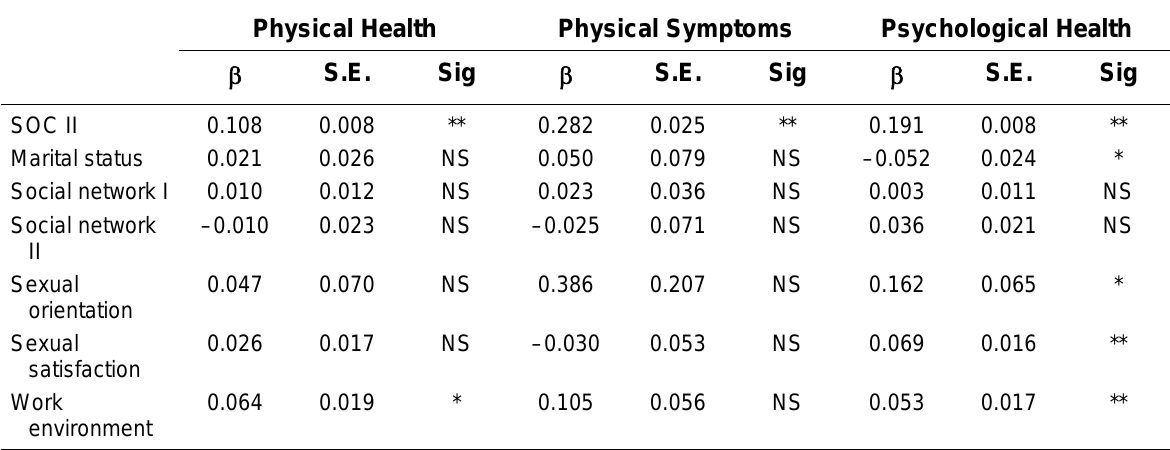
Model 3 (Life Form Variables), Linear Regression Analysis with Health as the Dependent Variable